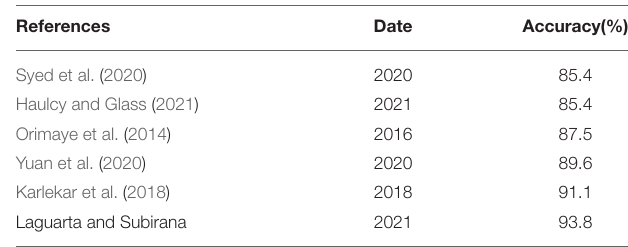
TABLE 1 | A review of other AD diagnostic algorithms on the same dataset from Lyu